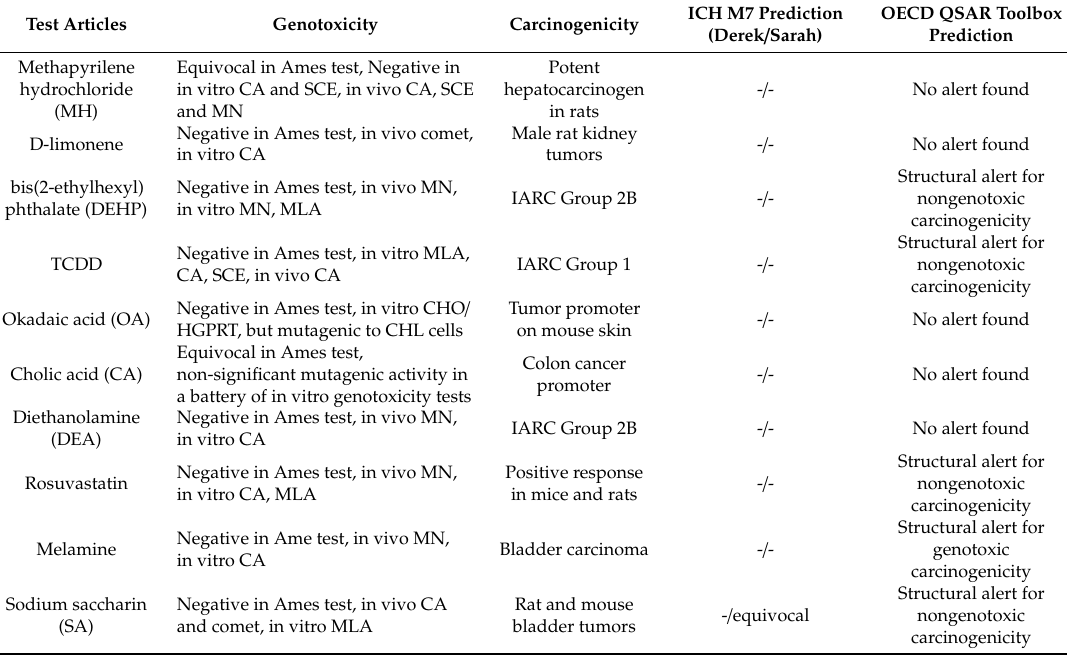
Table 1. Published genotoxicity and carcinogenicity results for the test articles.